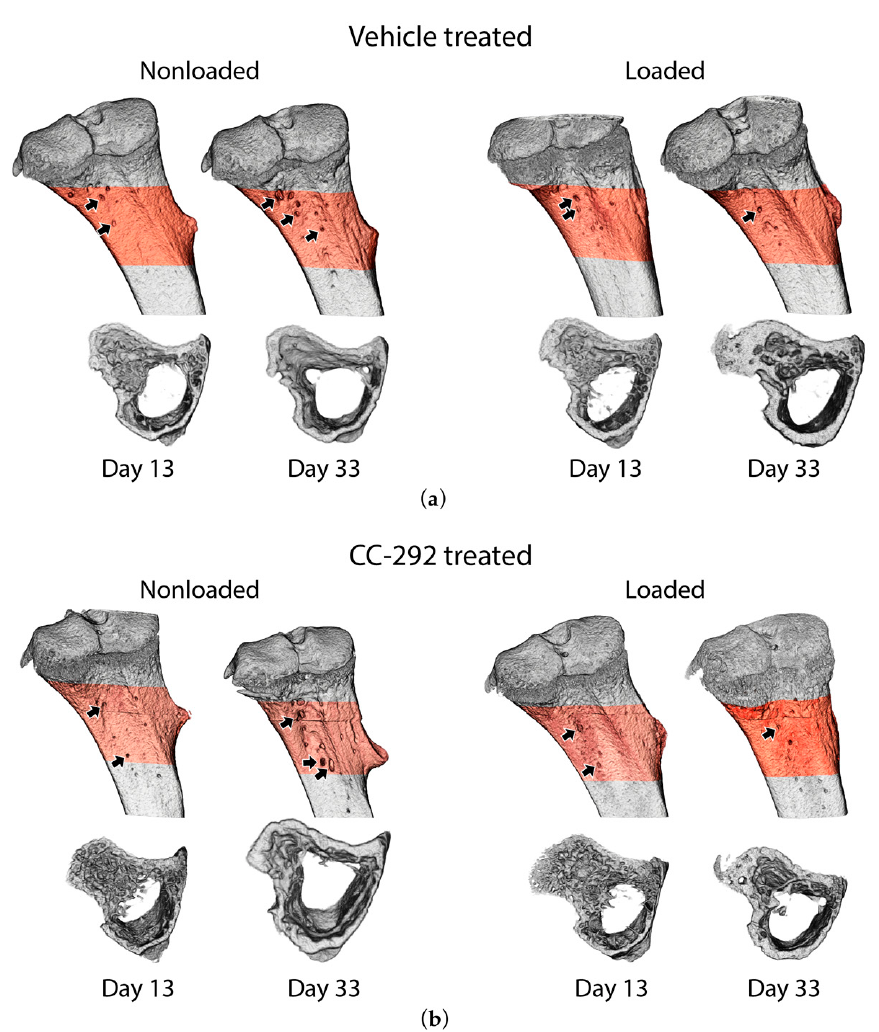
Figure 2. 3D renderings of the metaphyseal region of a nonloaded and a loaded tibia of vehicle and CC-292 treated MM-injected mice, respectively. ( a ) Representative 3D renderings of vehicle treated mice are depicted at days 13 and 33 of the experiment. ( b ) Representative 3D renderings of CC-292 treated mice are depicted as well. The arrows mark osteolytic lesions through the cortex. The volume of interest (VOI) for microCT analysis is marked in red.